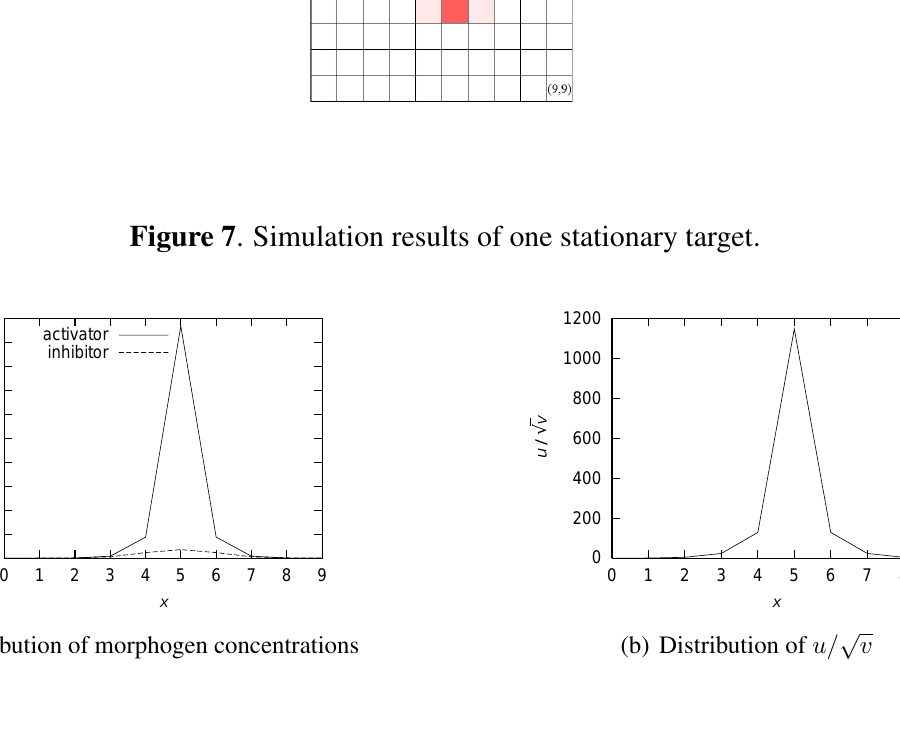
Figure 8 . Transition of volume and video coding rate against number of